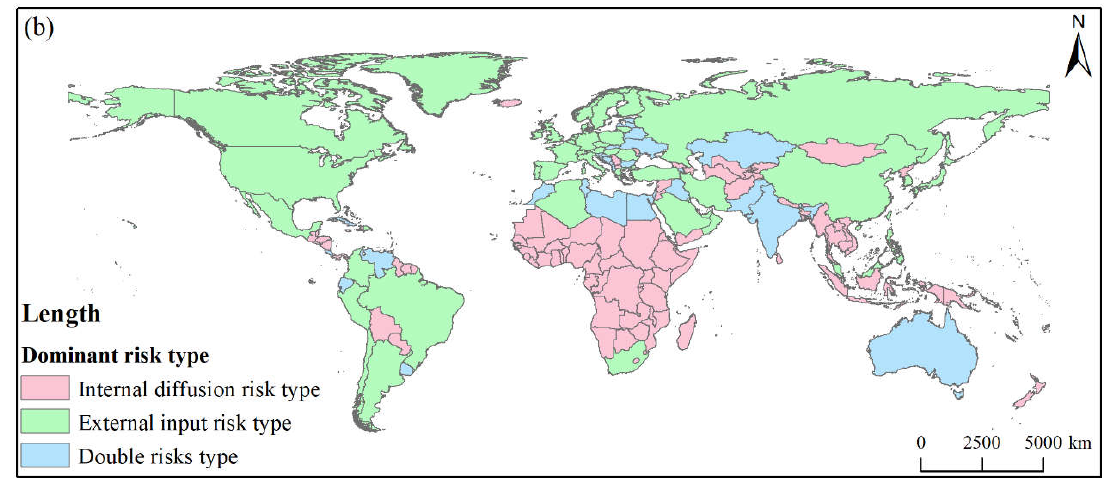
Figure 7. Spatial pattern of comprehensive risk ( a ) and dominant risk type ( b ).